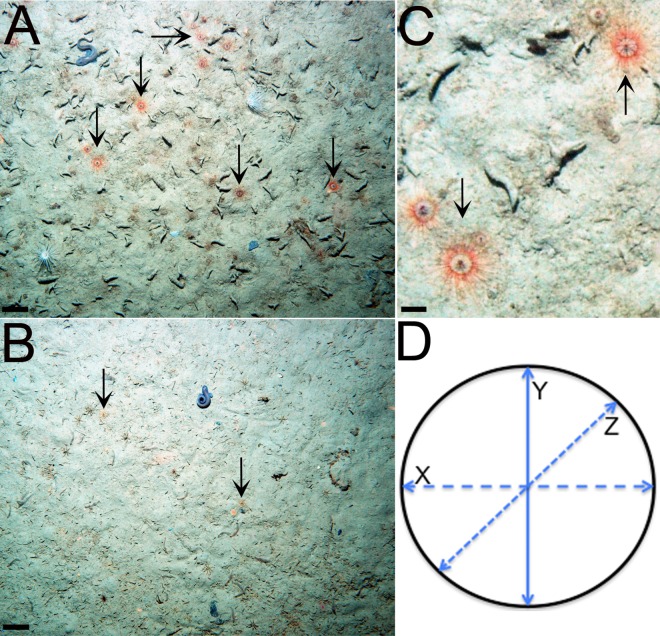
Representative images of the seafloor and the trachymedusa Ptychogastria polaris in Andvord and Flandres Bays.Typical view and occurrence of P. polaris in the (A) outer basin of Andvord Bay and (B) inner basin A of Flandres Bay. Scale bars are 1 cm. (C) Close-up view of P. polaris in the outer basin of Andvord Bay. Scale bar is 2 cm. (D) Bell diameter measurements taken in three horizontal directions (X, Y and Z). Note that black arrows are used to indicate the position of a representative selection of individual P. polaris in panels (A-C). Other P. polaris not identified by black arrows in the field of view were still counted.